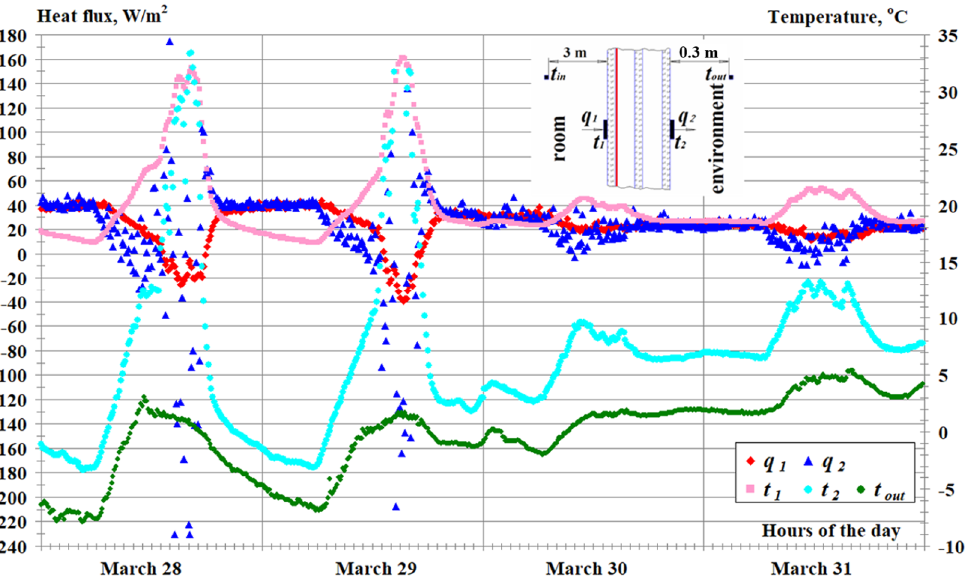
Figure 10. Dynamics of thermal characteristics of a two-chamber double-glazed window, oriented strictly to the west. strictly to the west.